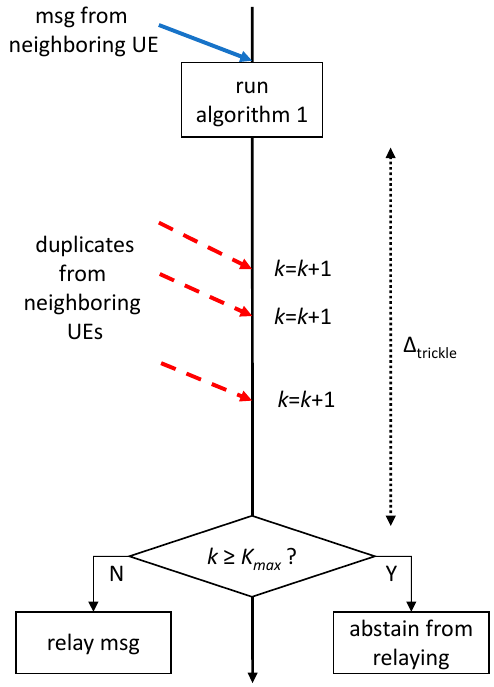
Figure 5. Relaying operations at the UE application.